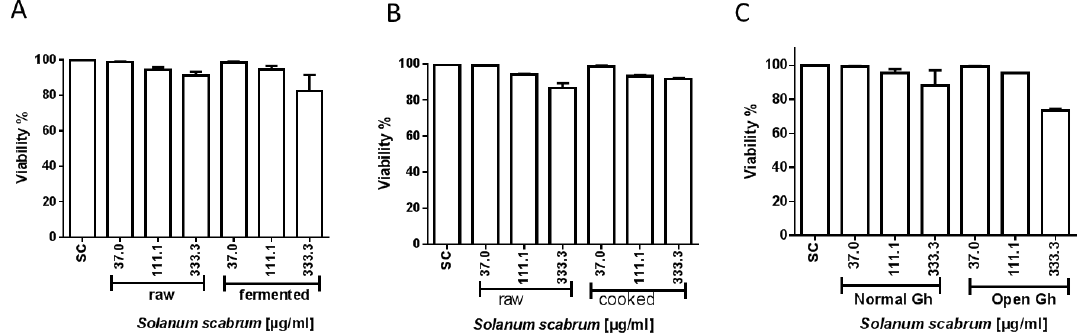
Figure 6. Cytotoxicity of ethanolic extracts of S. scabrum . HepG2 cells were treated for 48 h with the leaf extracts and cytotoxicity determined using trypan blue dye exclusion test. Results are given for ( A ) raw vs. fermented, ( B ) raw vs. cooked and ( C ) normal greenhouse vs. open green house experiments. Data are means ± SEM of three independent experiments (SC = solvent control, 0.7% ethanol).